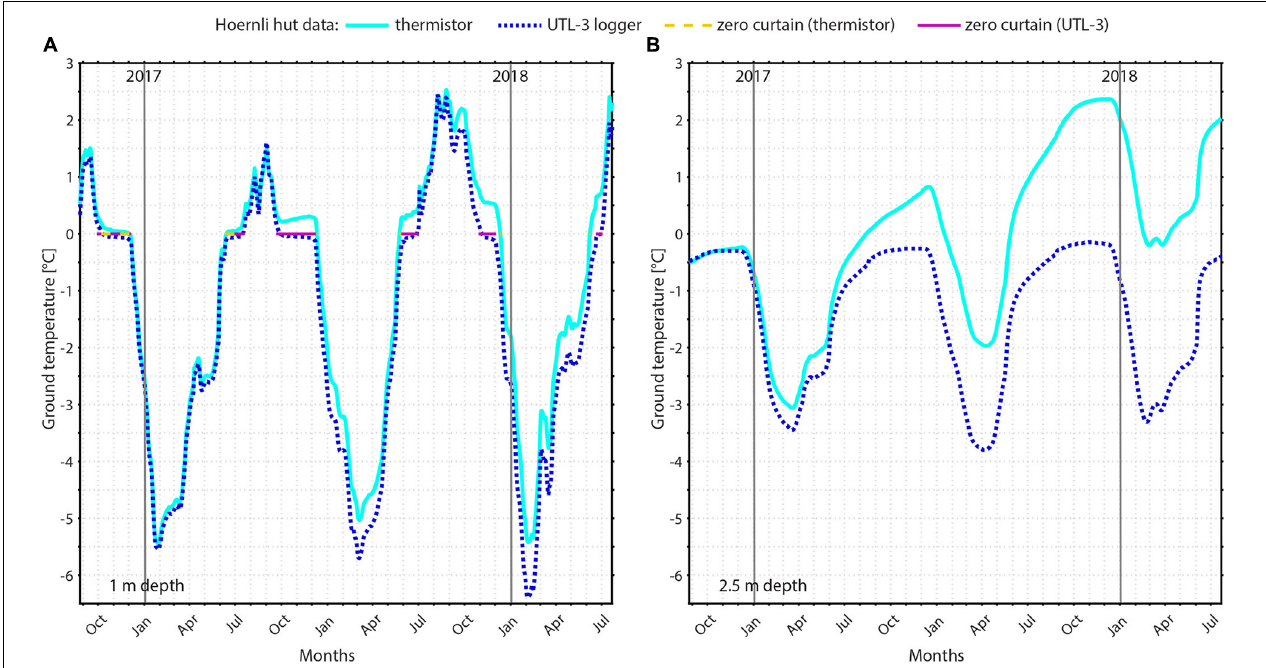
FIGURE 3 | Evolution of ground temperatures measured in the Hoernli hut borehole at (A) 1 m and (B) 2.5 m depth between September 2016 and July 2019. To verify the thermistor measurements (light blue lines) temporary UTL-3 loggers (dark blue dotted lines) were installed in parallel. Yellow dashed (thermistor) and solid purple (UTL-3) lines indicate zero